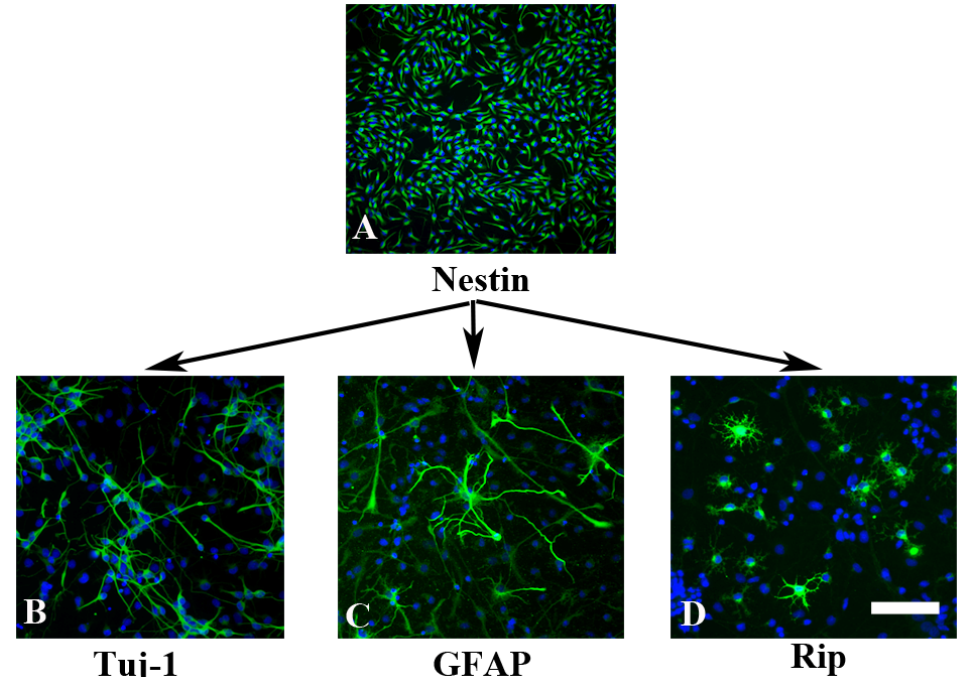
Figure 1. Characterization on NPCs. ( A ) NPCs were isolated from E-14.5 rat cortex and cultured in bFGF- and EGF-supplemented culture medium. Cells were either bipolar or multipolar with immunoreactive for nestin; ( B – D ) When bFGF and EGF were removed from the culture and replaced with 1% FBS for 5 days, NPCs successfully differentiated into β III-tublin-positive neurons ( B ); GFAP-positive astrocytes ( C ); and Rip-positive oligodendrocytes ( D ). Scale bar: 150 µm in A; 50 µm in